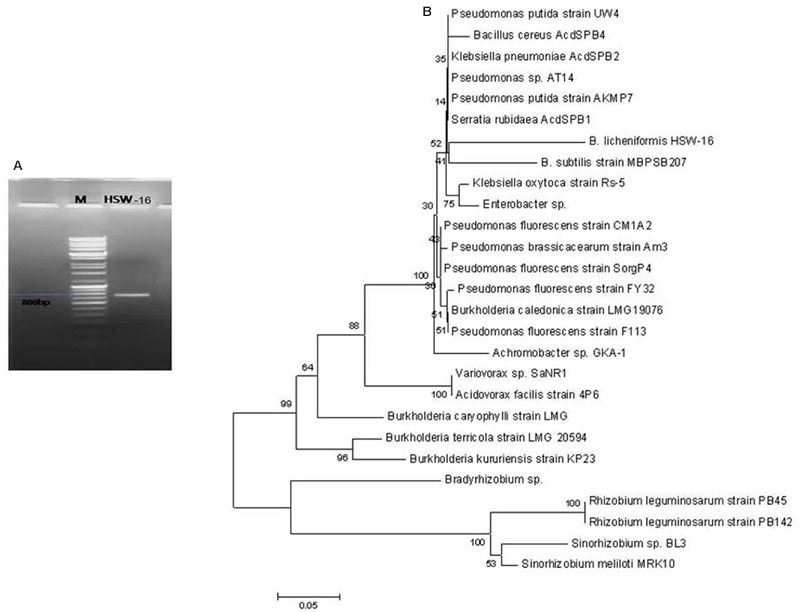
Amplification of AcdS gene of B. licheniformis HSW-16. (A) Shows amplicon of AcdS (800 bp) of the isolate in Lane HSW-16 and DNA ladder mix (Fermentas, SM0331) in Lane M. (B) represents dendrogram based on AcdS gene sequence of test isolate and other species. Neighbor-joining method was performed using the software packages Mega version 6.0 at the bootstrap value of n = 1000.